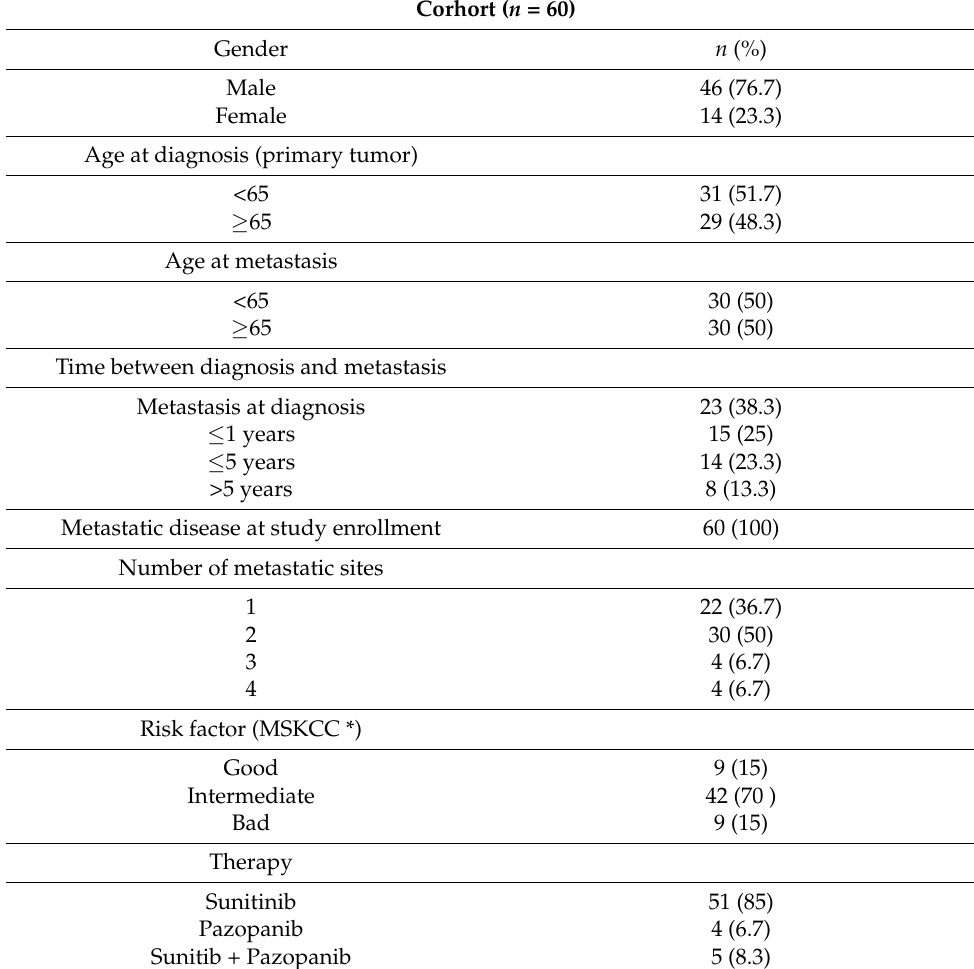
Table 1. Clinicopathological characteristics of the patients included in the study.